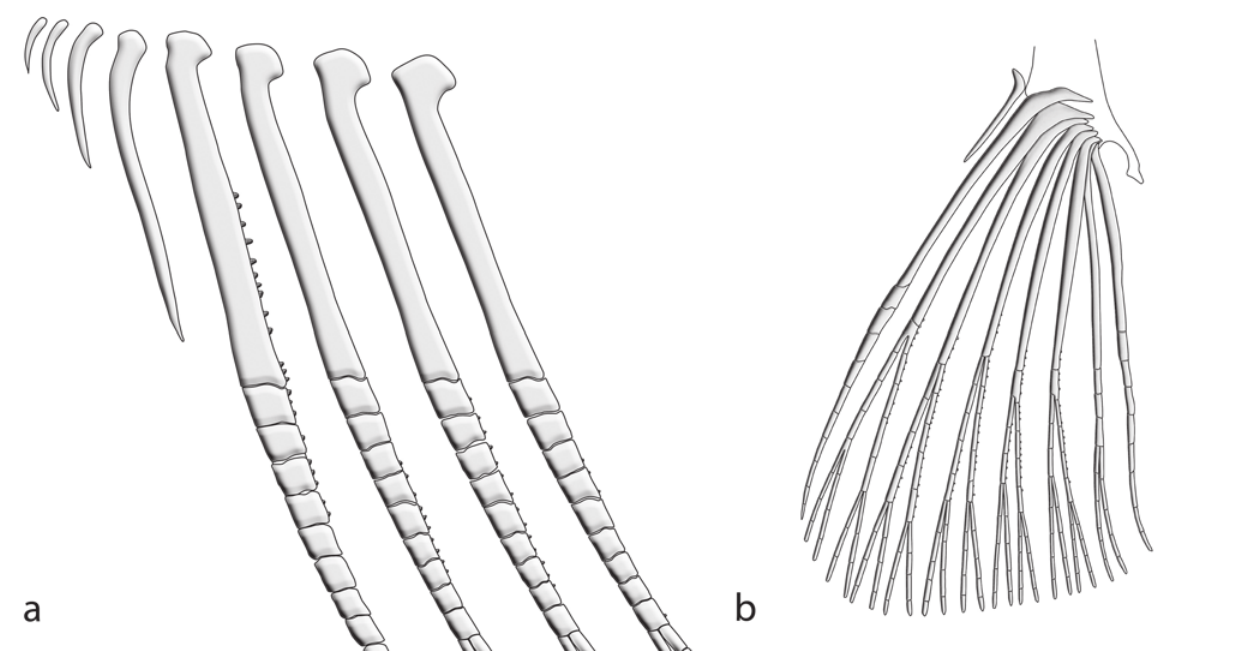
Fig. 18. Hooks on anterior anal-fin rays (a) and pelvic-fin rays (b) of Charax michaeli , MZUSP 33417, male, paratype, 80 mm